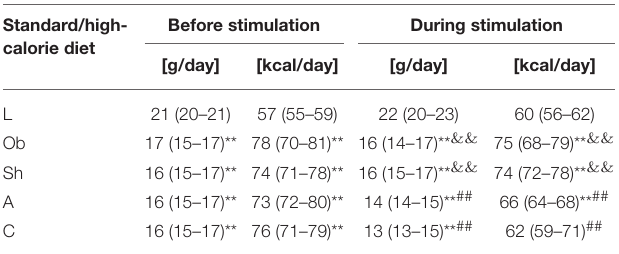
TABLE 1 | Daily food intake in grams/day and in kcal/day in intact rats on standard diet (L; n = 11) and on high-calorie diet (Ob; n = 10) and in the rats exposed to sham stimulation (Sh; n = 11), anodal stimulation of the right prefrontal cortex (A; n = 14) or cathodal stimulation of the left prefrontal cortex (C; n = 11) before and during stimulation part of the